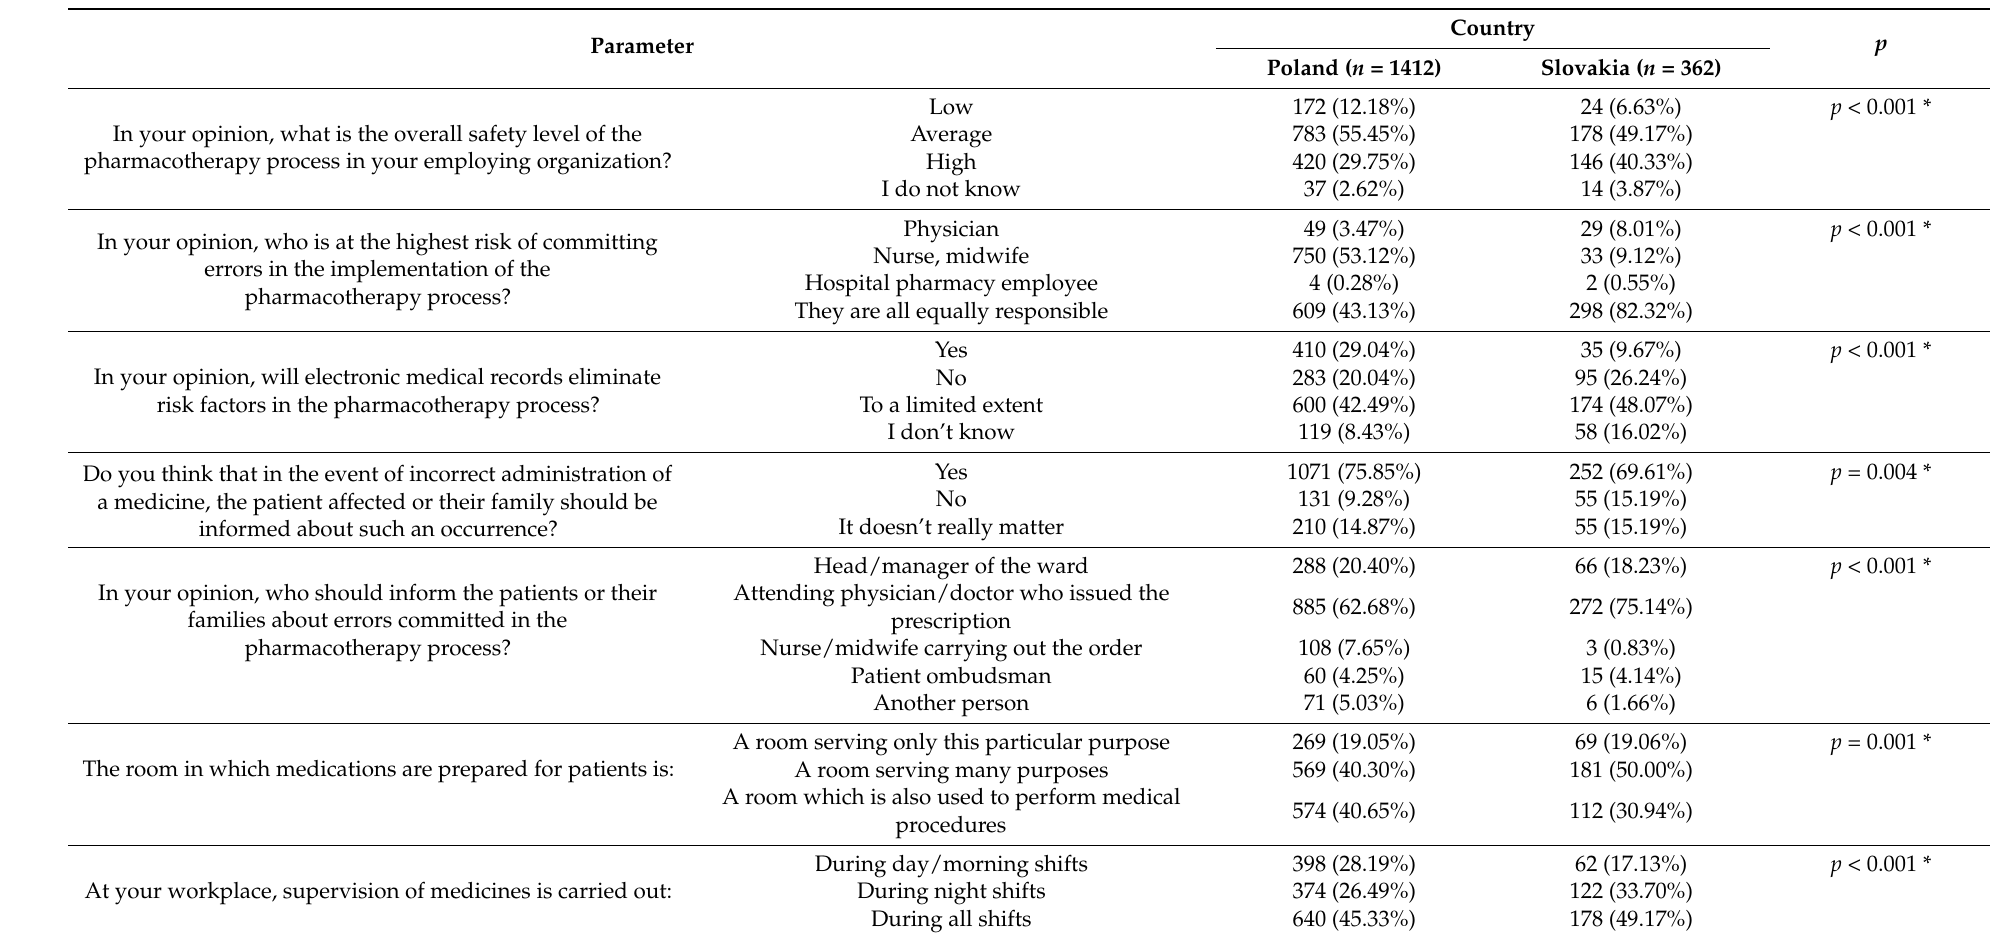
Table 4. Comparison of the results from outside the risk matrix for the group of nurses from Poland and Slovakia. Parameter